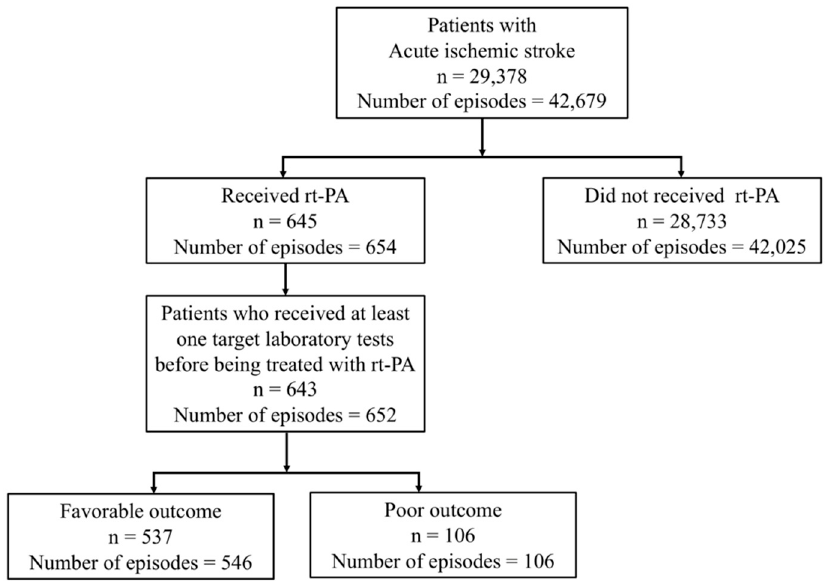
Figure 1. Study flow diagram. rtPA: recombinant tissue-type plasminogen activator. Table 1. Univariate analysis of the patient Table 1. Univariate analysis of the patient characteristics.